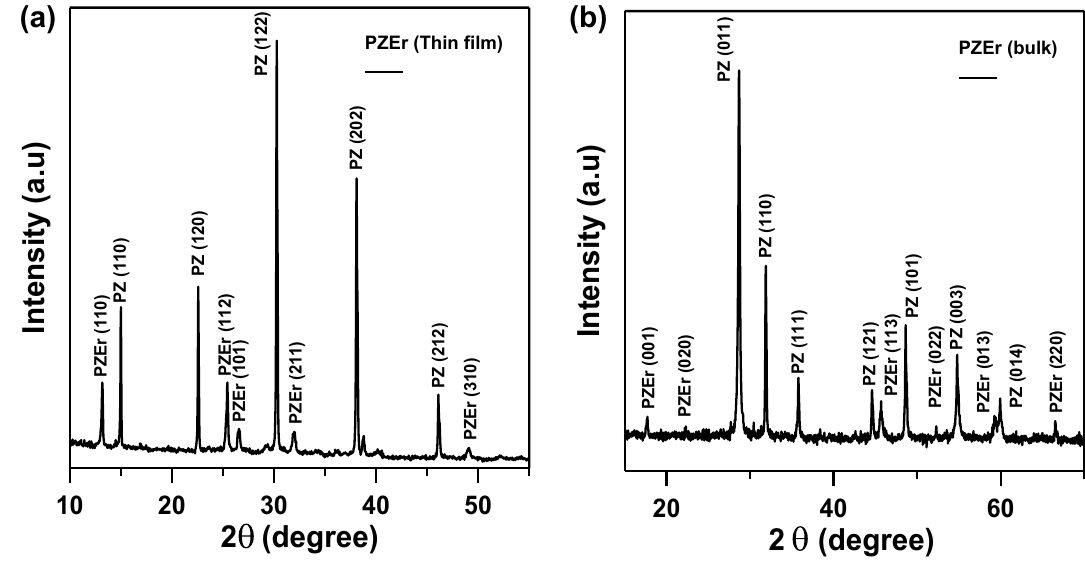
Figure 2. ( a ) XRD pattern of Er-doped PEZ thin film sample. ( b ) XRD pattern of Er-doped PEZ bulk sample.